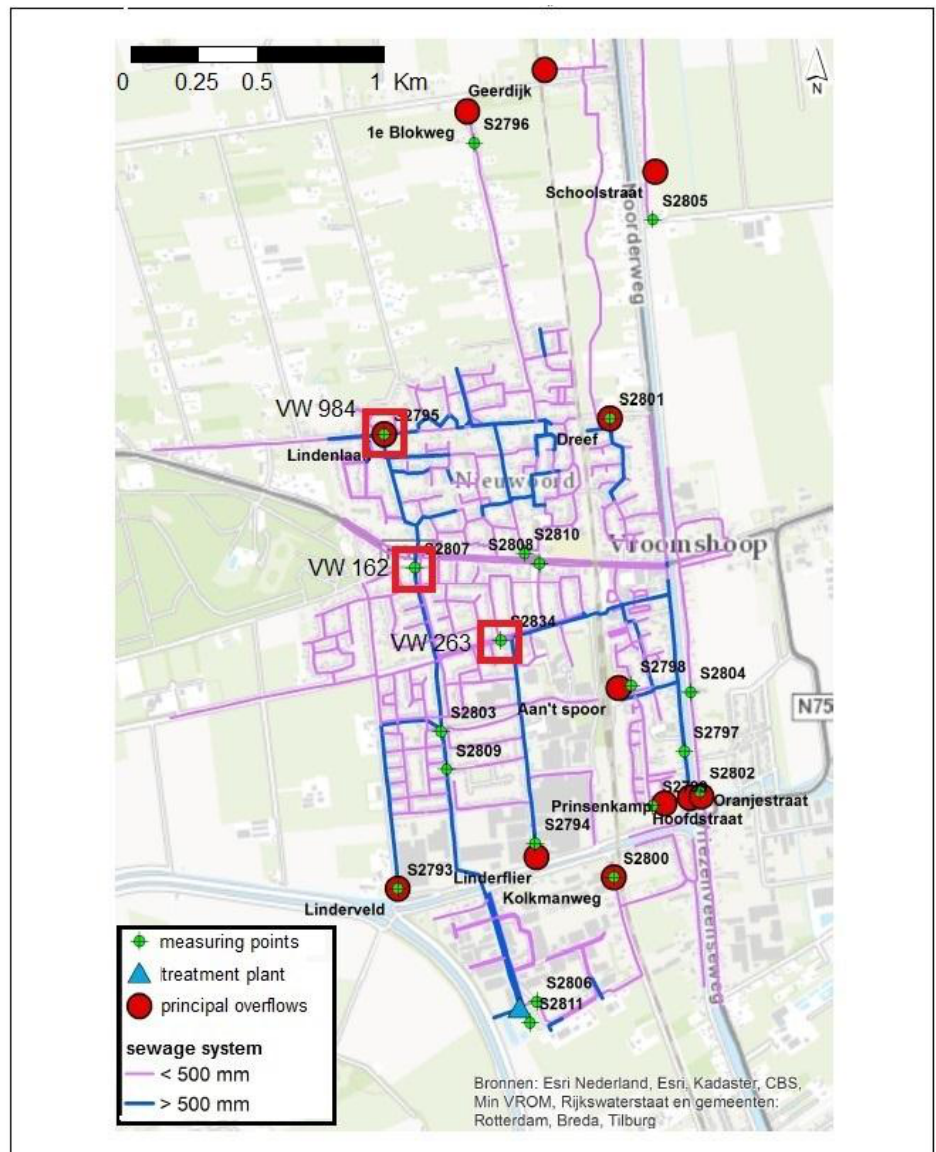
Figure 3. Simplified representation of the Vroomshoop InfoWorks model.